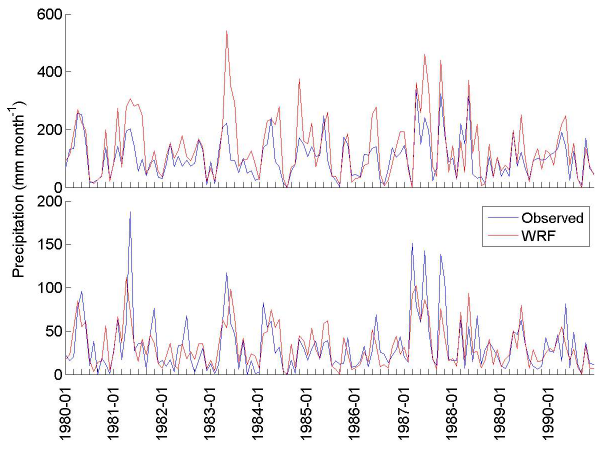
Fig. 2. Comparison of monthly time series over the period 1980– 1990 of observed precipitation and WRF downscaled ERA-40 data at the gauge location for Chaar-Tash (top) and Kyzyl-Jar (bottom).